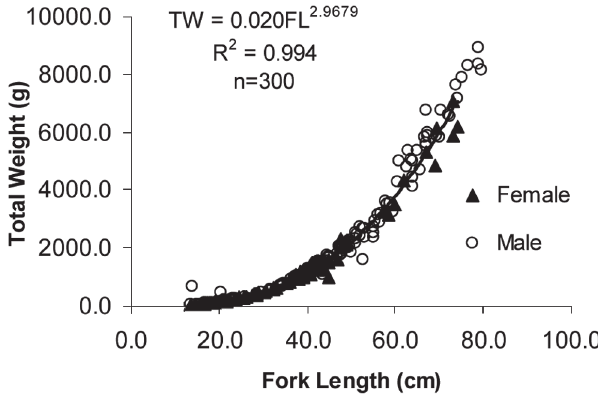
Fig. 9. Length-weight relationship for males and females of the dog snapper Lutjanus jocu from Abrolhos Bank.